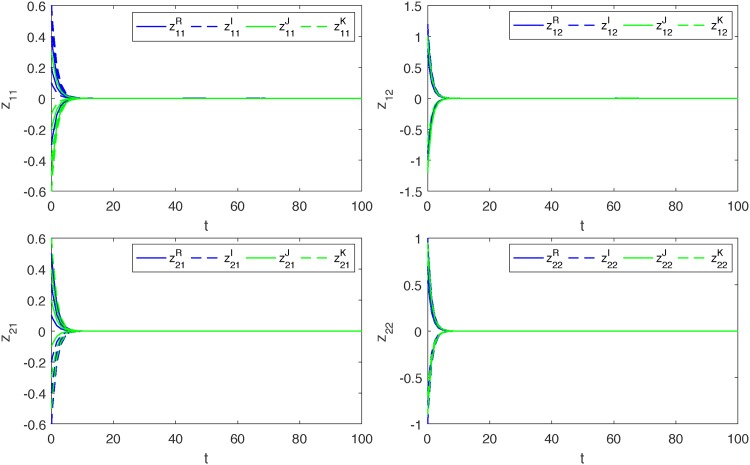
Synchronization.